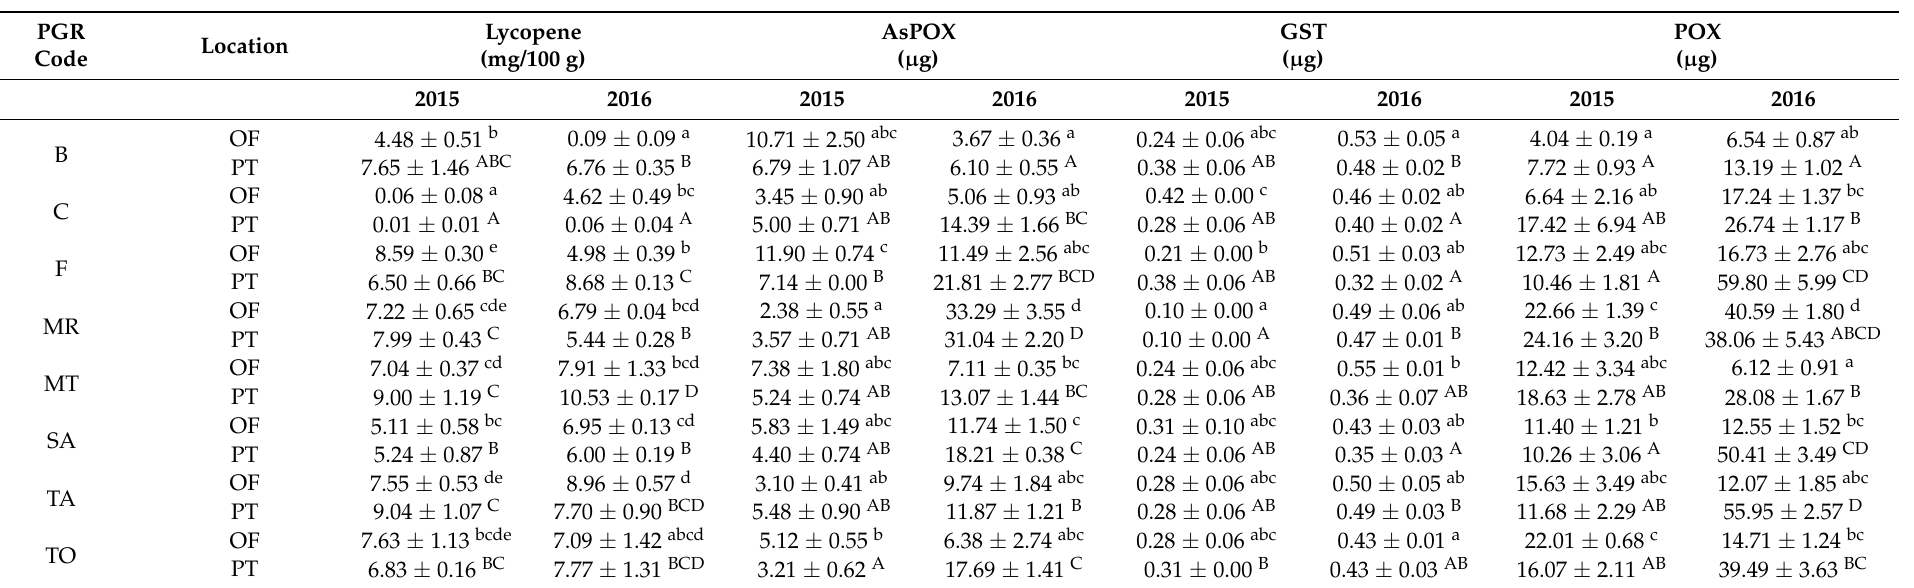
Table 5. Lycopene content and enzyme activity (mean ± sd) of the seven Hungarian tomato PGRs investigated and the control variety, measured by five different assays, in the open field and in the polytunnel, in 2015 and